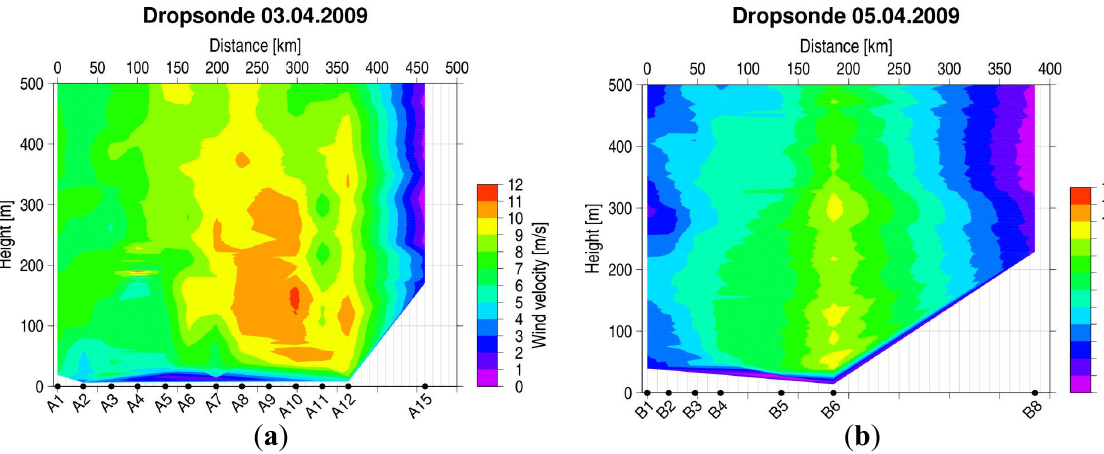
Figure 9. Dropsonde measurements of wind speed on 3 ( a ), 5 ( b ), 6 ( c ) and 10 April ( d ) 2009. The red line in panel d indicates the location of the front determined from the strongest horizontal temperature